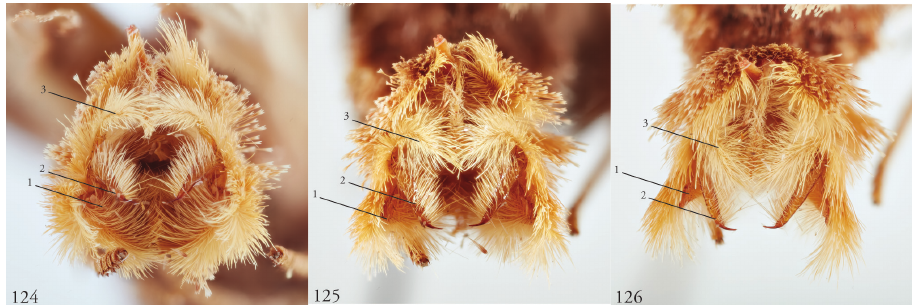
Figures 124–126. Leucosigma sp. near schausi, terminalia in situ , caudal view from a progressively dorsal angle . Structures labeled as in previous figures to indicate (1) sacculus; (2) cucullus and (3) dorsal process. DOMINICAN REPUBLIC: Dajabon Province 13km S. Doma de Cabrera ca. 400 m, 20–22 May 1973 Don & Mignon